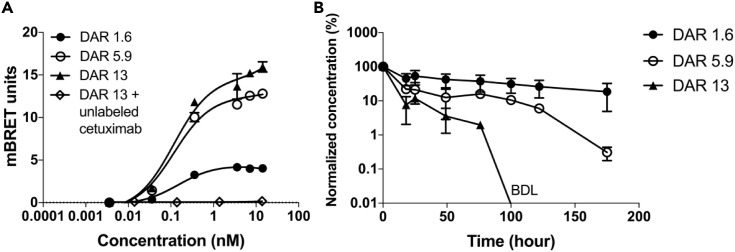
Evaluating the Effects of Dye-Antibody Ratios (DAR) on In Vitro Binding Affinity and In Vivo Pharmacokinetics(A) The binding affinities of DY605-cetuximab to NanoLuc-EGFR at various dye per antibody ratios (DARs) = 1.6, 5.9, and 13 were similar (0.15 ± 0.04, 0.12 ± 0.03, and 0.12 ± 0.03, respectively), whereas the maximum BRET signals increased (4.8 ± 0.3, 13.4 ± 0.6, and 15.6 ± 0.8, respectively).(B) High DAR is correlated with increased DY605-cetuximab clearance in vivo. Plasma concentrations were normalized to initial concentrations. Plasma concentrations below the detection limits were noted as BDL. For panels (A and B), each data point represents the mean value of three technical replicates. Data are presented as mean ± SD. BDL, below detection limit.